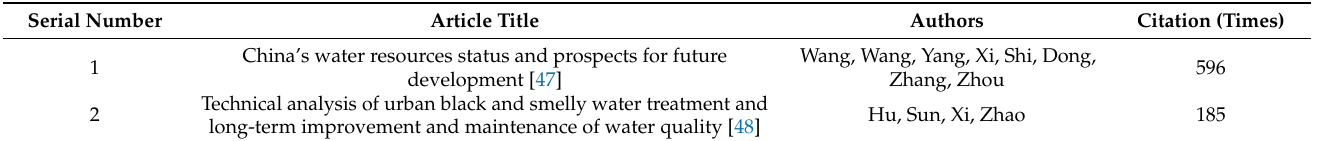
Table 7. Highly cited articles in CNKI from 1992 to